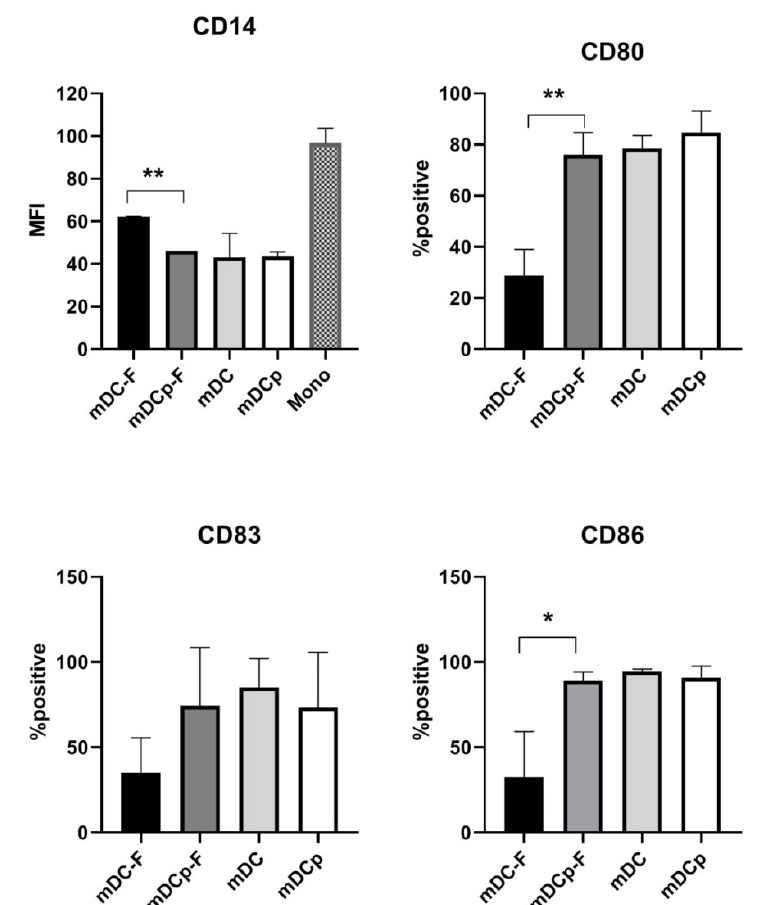
Figure 2. Phenotypic analysis of DC. Summarizing graphs represent the results of the FACS analysis on Fast and standard method DC both in presence (mDCp-F, mDCp) or absence (mDC-F, mDC) of PGE 2 . Down-regulation of CD14 (monocytes marker) is represented as MFI; variation of maturation markers (CD80, CD83, CD86) is represented as mean percentage of positive cells. Statistical bars on graph indicate the SD value. Significance denoted, * p < 0.05, ** p < 0.01.